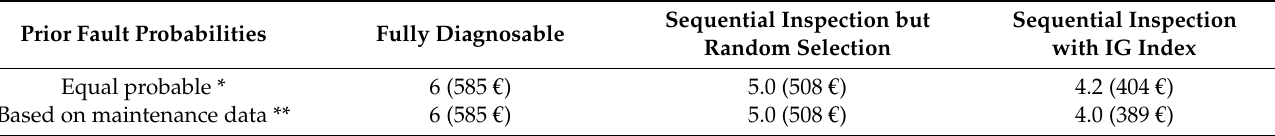
Table 4. Number of inspection measurements required for fault identification and cost. Three schemes: fully diagnosable, proposed sequential inspection with random selection of inspections, and proposed sequential inspection with IG index. Two situations: all fault probabilities are equal; fault probabilities are defined according to maintenance data.